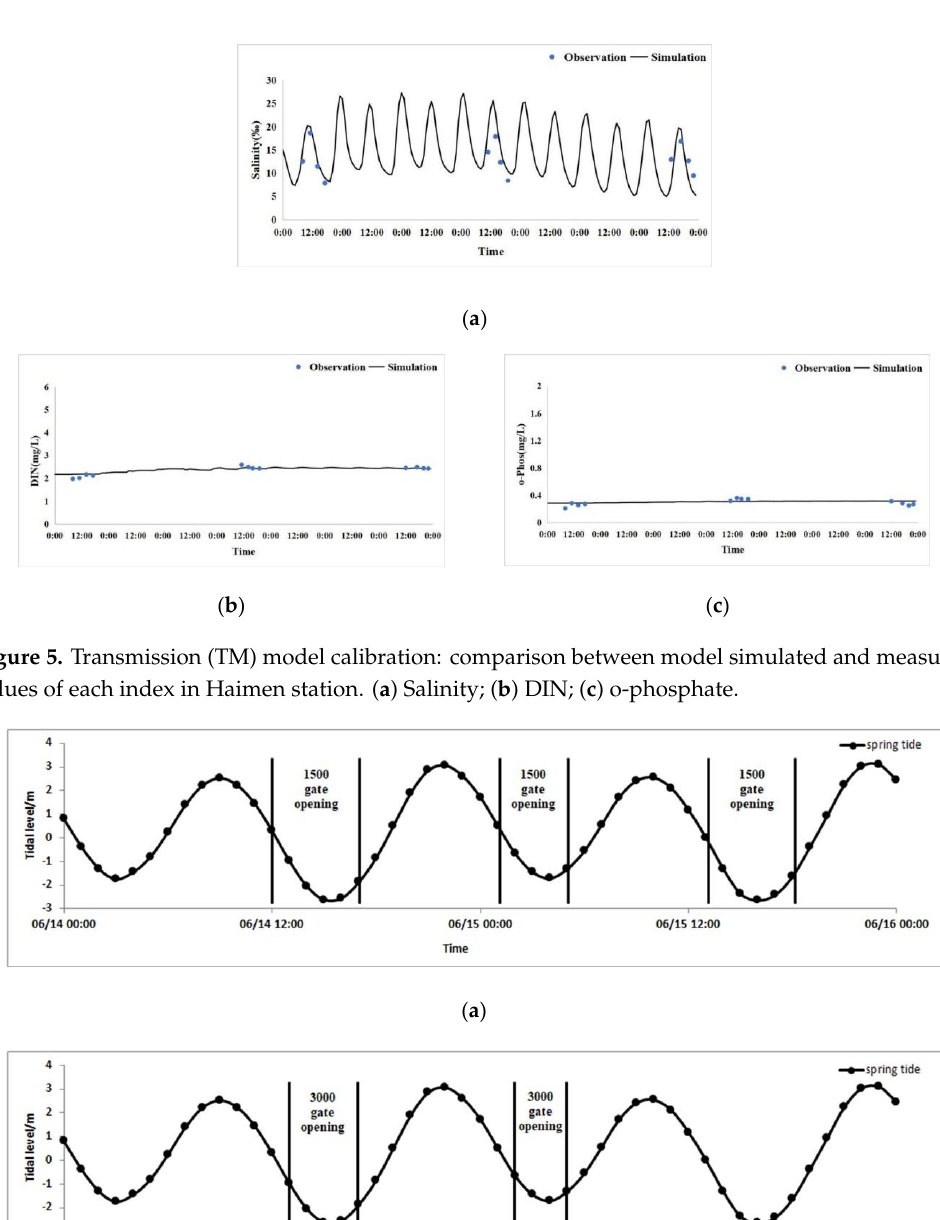
( b ) Figure 4. Hydrodynamic (HD) model calibration: comparison between model simulated and measured tidal level. ( a ) Haimen; ( b ) Langjishan. Table 1. Details of the variables used as inputs in HD module. Parameter Value Used Manning’s number (i.e., 1/Manning’s coefficient) 90 m 1/3 /s* Smagorinsky coefficient–Eddy viscosity formulation 0.28 Dry and flood h dry = 0.005 m h flood = 0.005 m h wet = 0.005 m * The value of Manning’s number recommended in the MIKE operation manual is between 30 and 50, which is mostly for the sandy river. Jiao (ling) jiang River is a tide influence river, where fine-grained